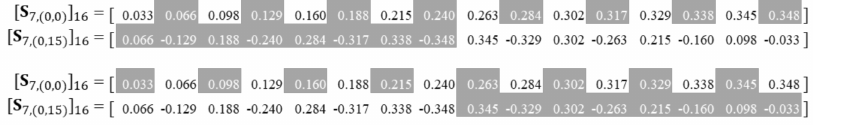
Figure 10. An example of patterns observed between two consecutive row vectors of 16-point DST-7 transform